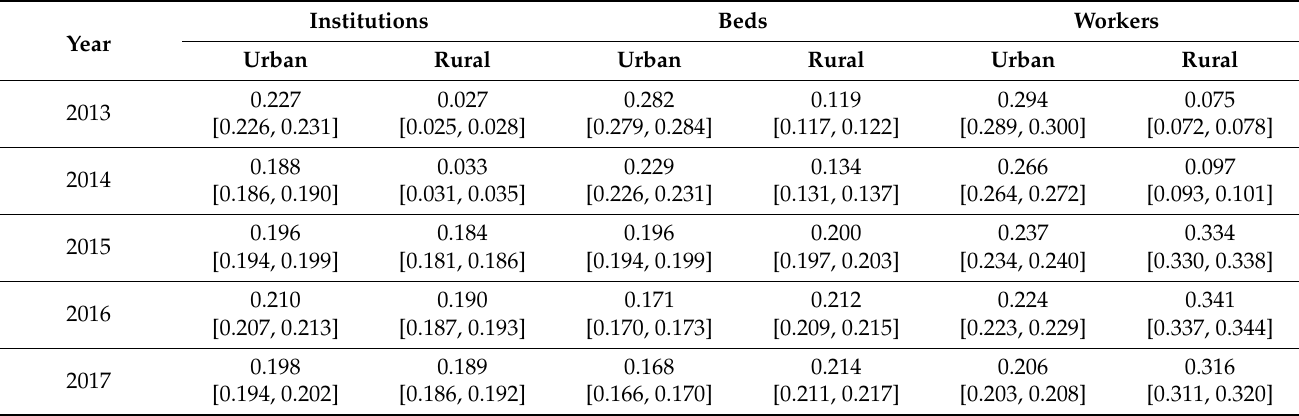
Table 4. Gini coefficients for LTC resource distribution